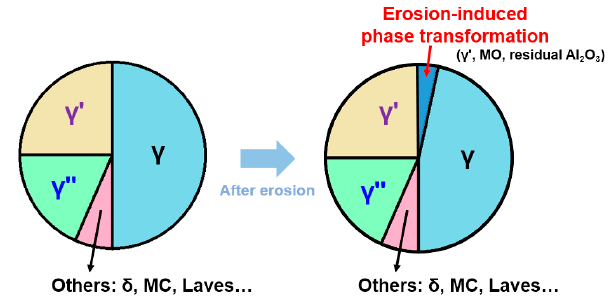
Figure 15. Schematic diagram of the IN718 phase transformation between pre and post erosion.